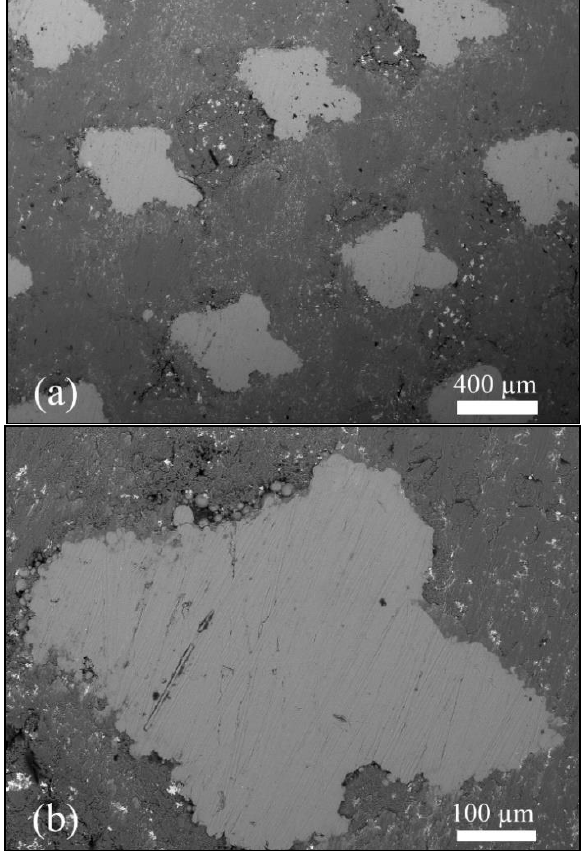
Figure 5. SEM micrograph of TiO 2 –2.5% Ag and Ti6Al4V lattice structure (1 mm unit cell size) taken at ×50 magnification ( a ) and ×200 magnification ( b ).